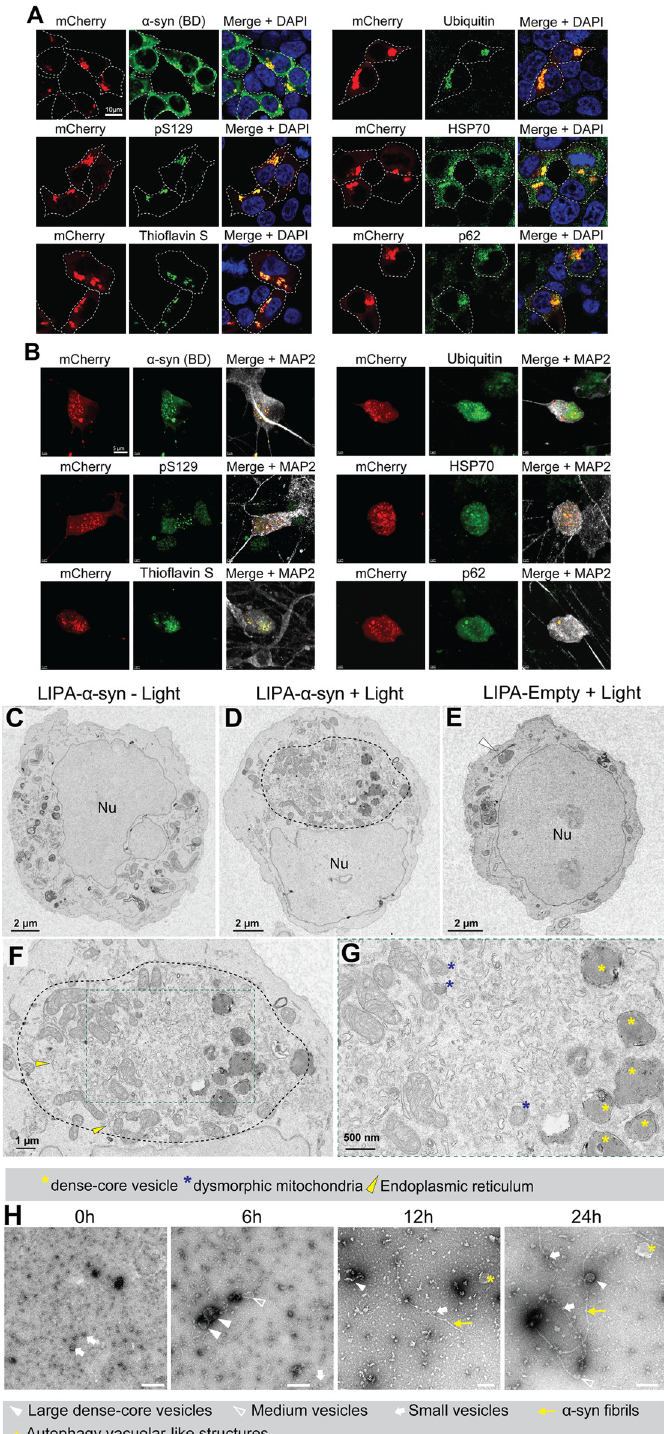
Fig 2. LIPA- α -syn inclusions recapitulate authentic LB features in cell culture. ( A ) Confocal images of HEK-293T cells overexpressing LIPA- α -syn exposed to blue light for 12 hours (0.8 mW/mm 2 ) and stained with LB markers: α -syn (BDlab), phosphorylated α -syn at S129 (pS129), ThS, ubiquitin, HSP70, and p62 ( n = 5) (scale bar = 10 μ m). ( B ) Confocal images of hiPSC-derived human neurons overexpressing LIPA- α -syn exposed to blue light for 6 hours (0.4 mW/mm 2 ) and stained with LB markers: α -syn (BDlab), phosphorylated α -syn at S129 (pS129), ThS,